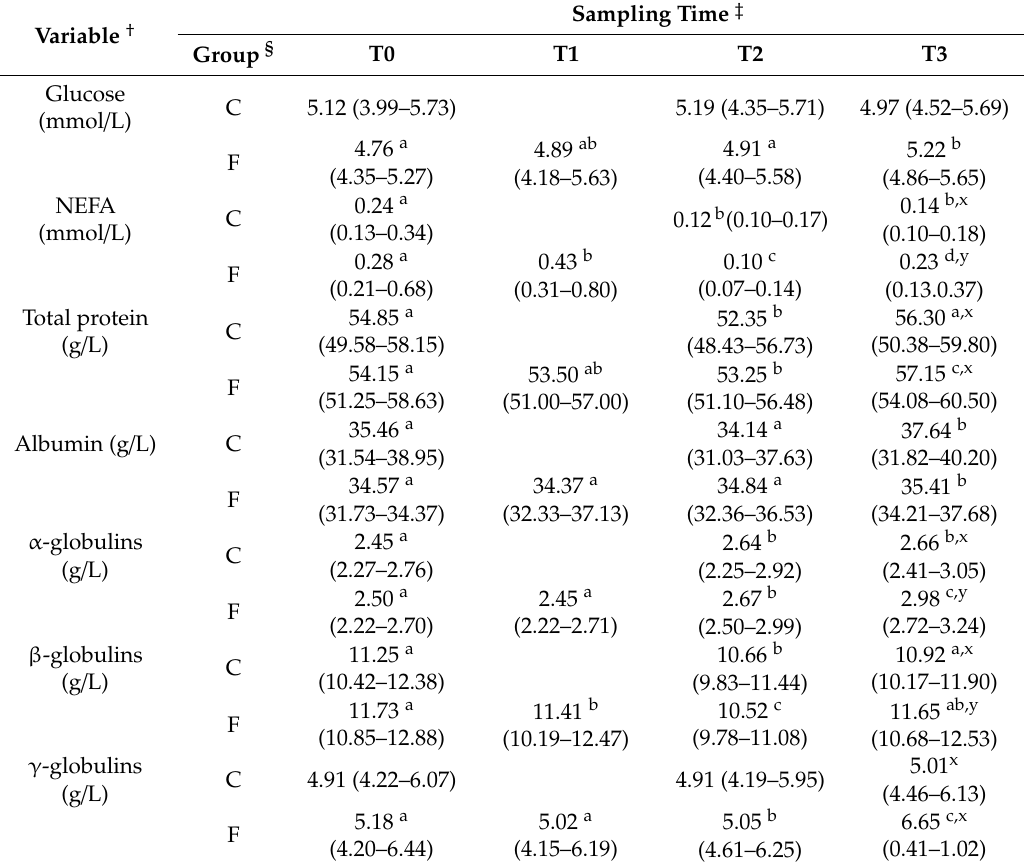
Table 2. Biochemical parameters (median value and 25th and 75th percentile values) of fattening lambs at di ff erent blood sampling times throughout the fattening